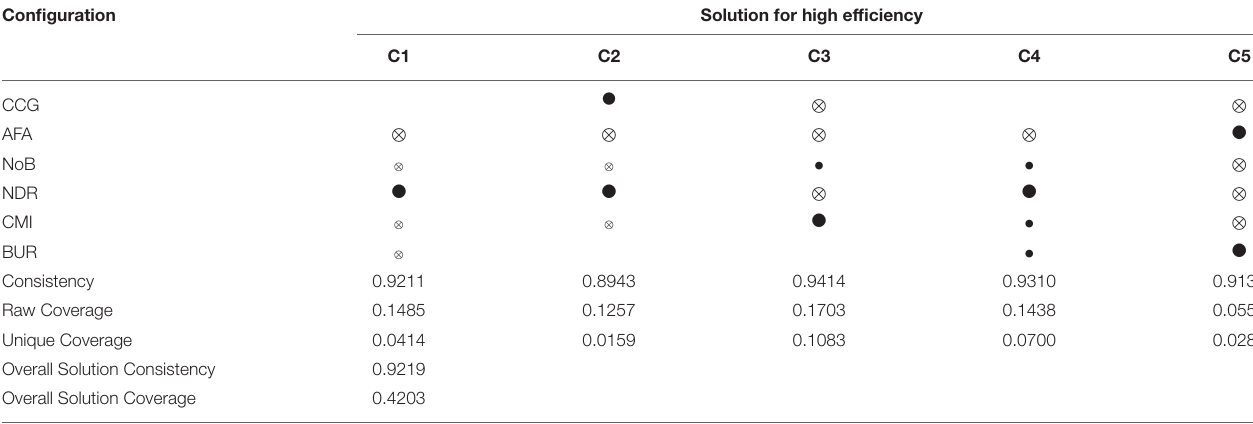
TABLE 5 | Configuration of conditions for high efficiency.